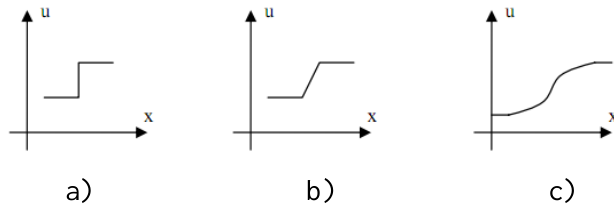
Figure 10. Filter result: a) Sobel, b) Laplace, and c)